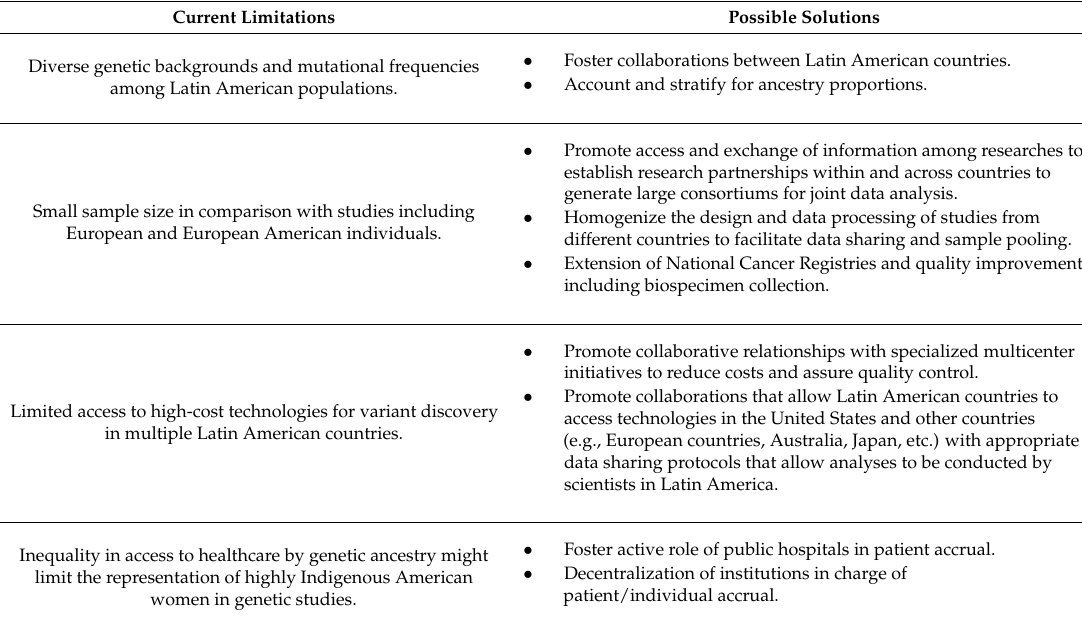
Table 2. Breast cancer genetic epidemiology in women of Latin American origin: Current limitations and possible